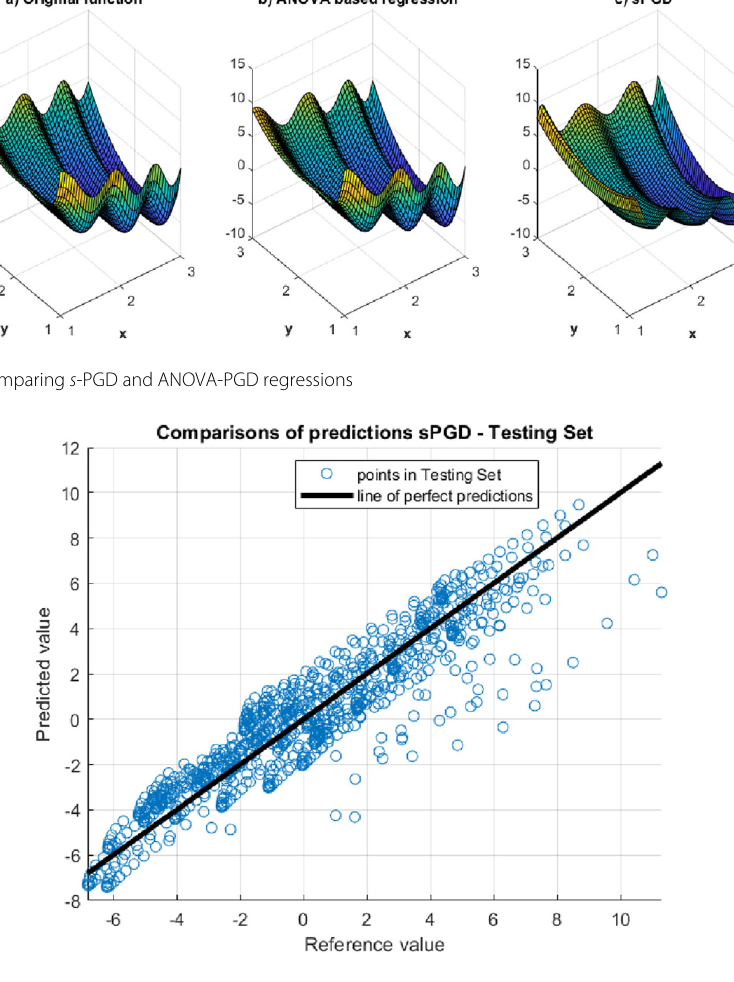
Fig. 14 Problem defined in Eq. (4.6): Comparison of predicted s -PGD values with the reference ones in the testing set (the black line represents a perfect